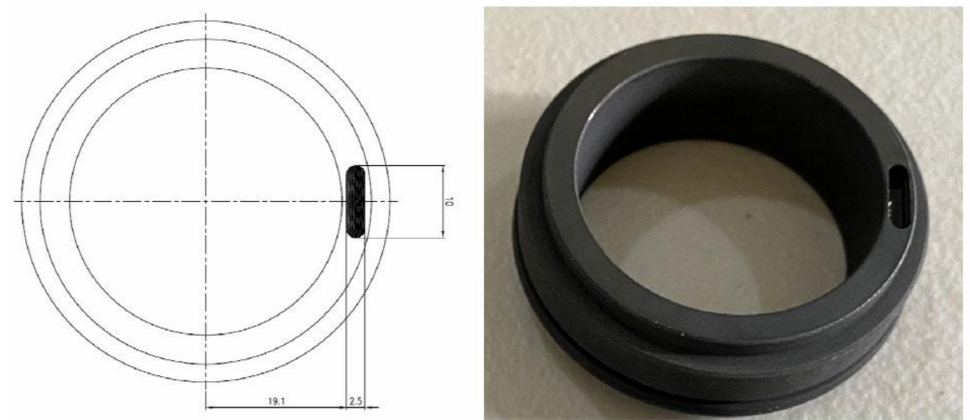
Figure 4. Mechanical seal scratch